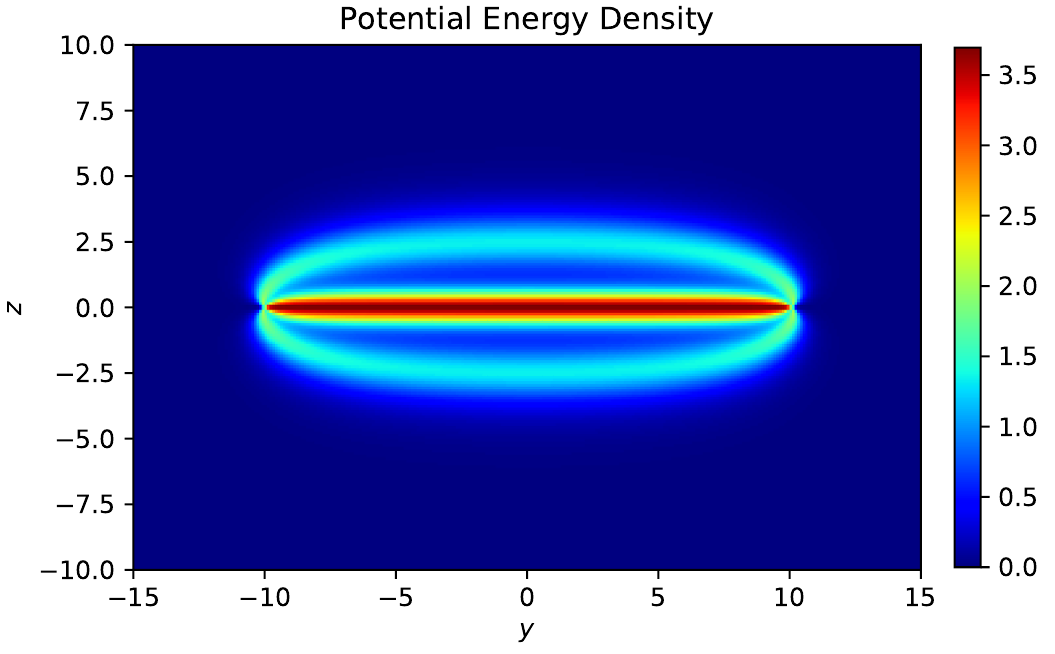
Figure 22. “Gluon confinement” by a triple string. Plotted is the potential energy density of an N = 5 confining string with a root-lattice weight α 1 . Uniquely, this configuration possesses three distinct flux tubes: two BPS 1-walls and a single BPS 3-wall (the two distinct vacua inside the triple-string configuration are now the k = 1 and k = 4 vacua of SU(5) SYM, while the string is embedded in the k = 0 vacuum). At large enough separation, this triple string should break due to the pair production of W -bosons, i.e., the adjoint Wilson loop should show perimeter